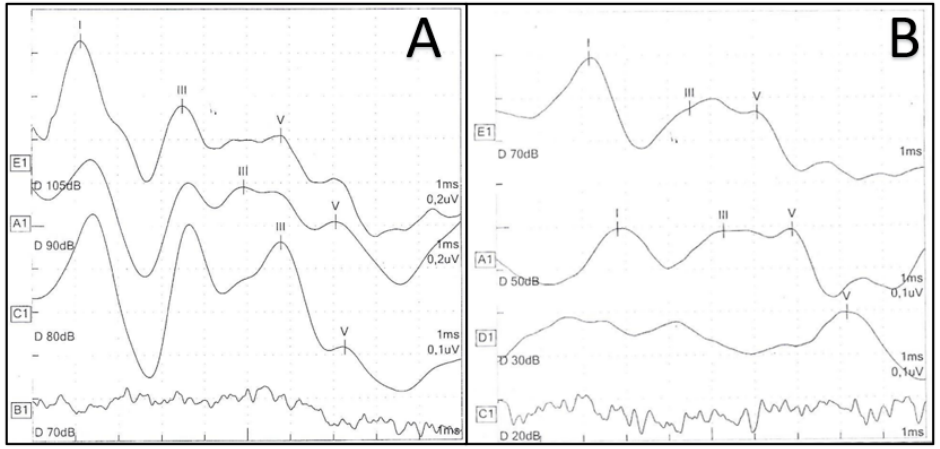
Figure 1. Example of hearing threshold improvement of the right ear from 80 db nHL at the first ABR ( A ) to 30 db nHL at the last ABR ( B ).